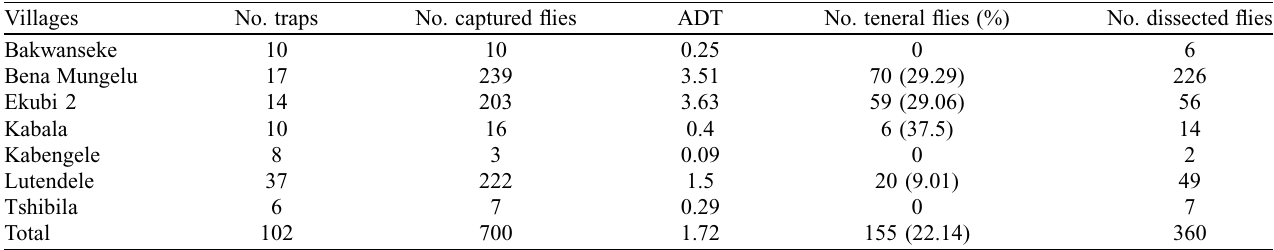
Table 1. Results of entomological surveys. Villages